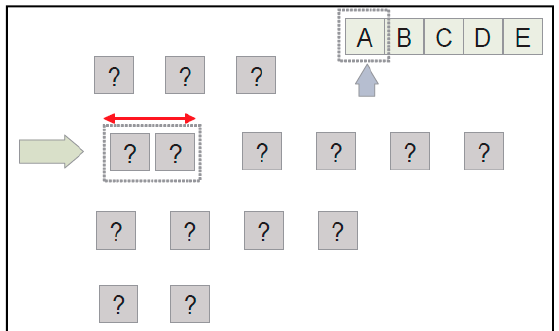
Figure 10. Validation of the first expected character “A” with the first acquired shape of the band has failed. We build a new acquired shape by merging the first shape acquired with the one immediately following, and we repeat the validation.